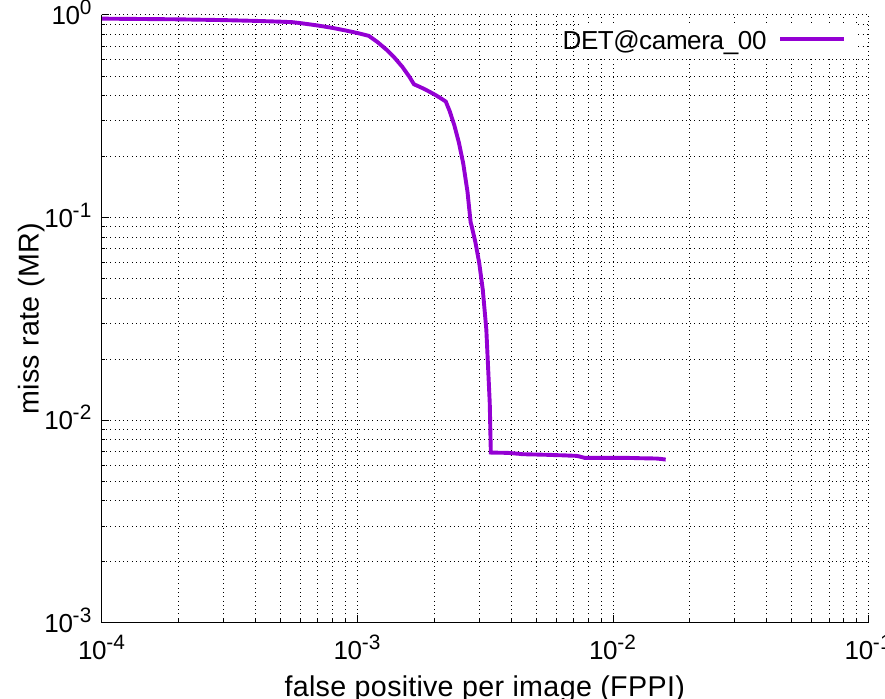
Figure 15. DET curves @ Camera_00,